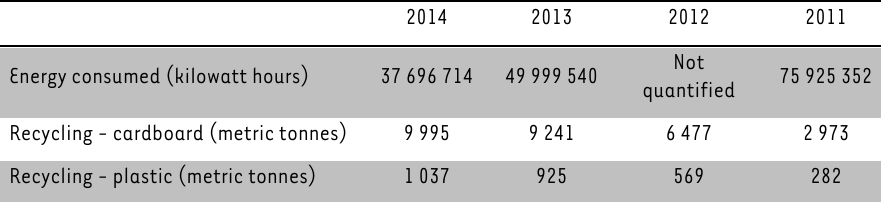
TABLE 4: SPAR environmental initiatives from 2011 to 2014